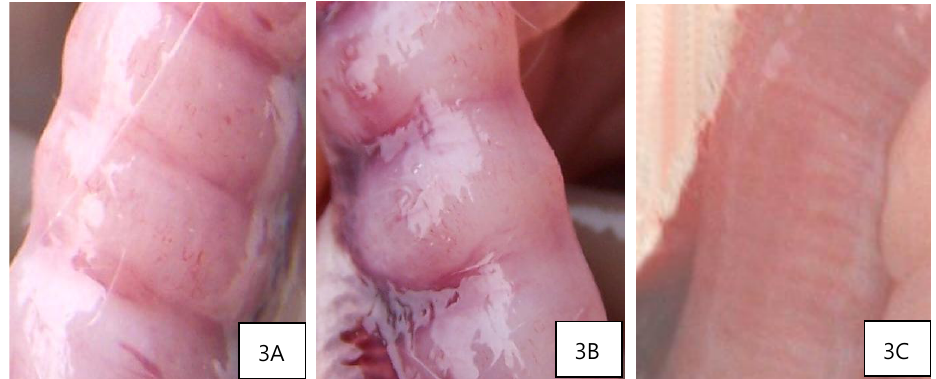
Figure 3. Appearance changes in the uterus. 3A. Uterus of control group rats. 3B. Uterus of L-IFN-  rats. 3C. Uterus of H-IFN-  rats.